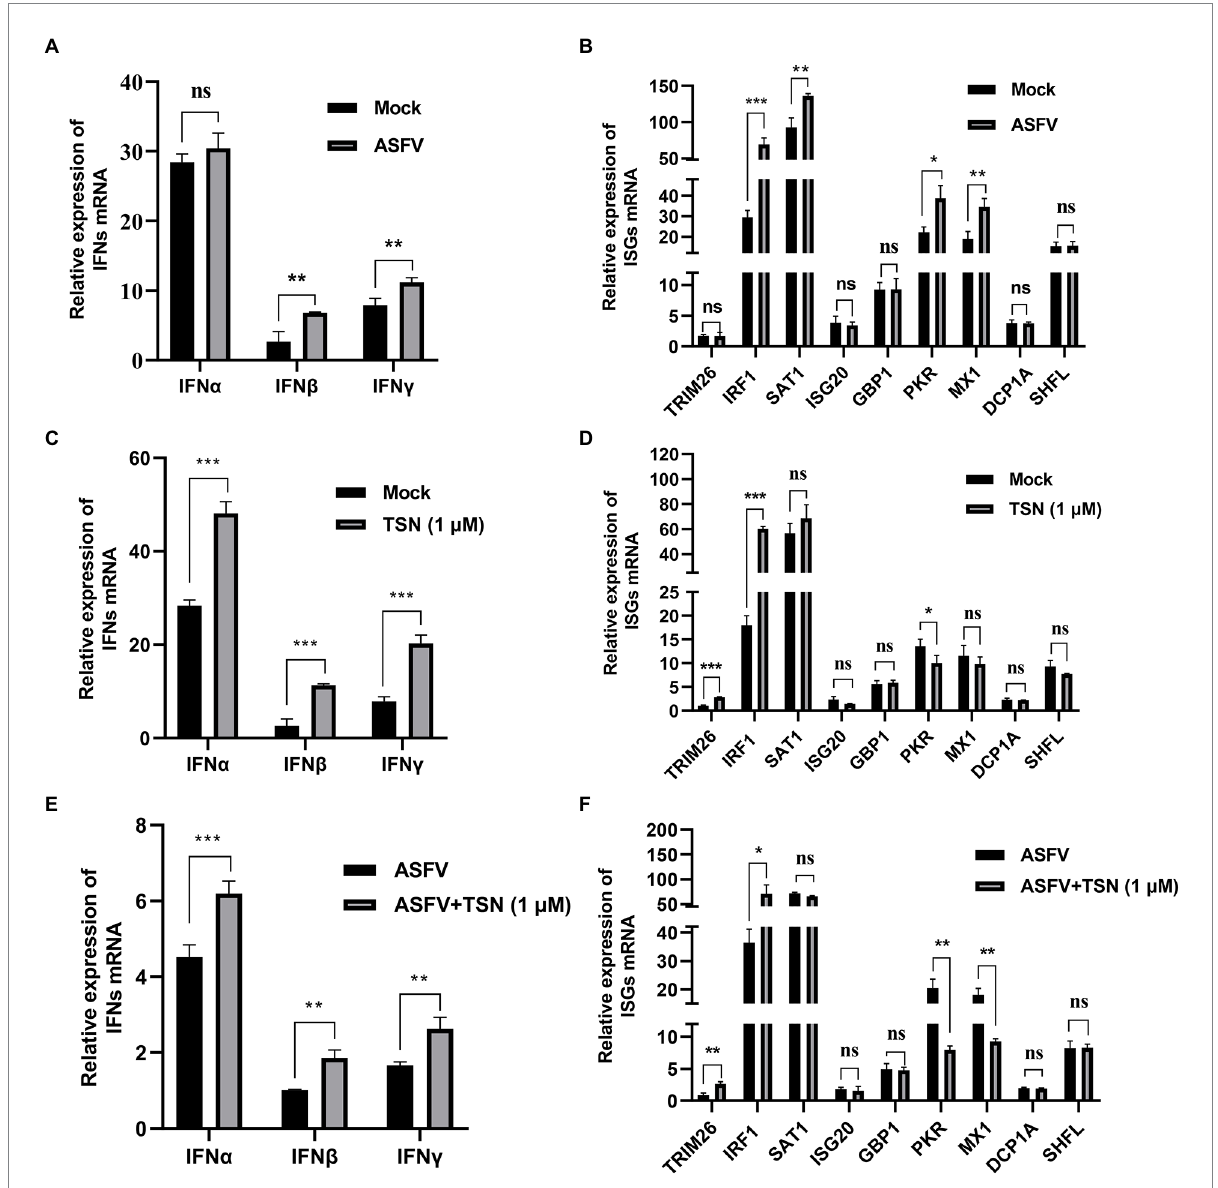
FIGURE 9 Effects of TSN on the mRNA expression of IFNs and 9 ISGs in PAMs. 0.014 MOI ASFV infected the PAMs for 24 h to test its effect on the expression level of IFNs (IFN α , IFN β and IFN γ ) and 9 ISGs (TRIM26, IRF1, SAT1, ISG20, GBP1, PKR, MX1, DCP1A and SHFL). Besides, 1 μ M TSN was added to PAMs with or without ASFV infection (0.014 MOI) for 24 h to test its effect on the expression of IFNs (IFN α , IFN β and IFN γ ) and 9 ISGs (TRIM26, IRF1, SAT1, ISG20, GBP1, PKR, MX1, DCP1A and SHFL). The vertical axis shows the relative expression level (fold-change) of IFNs or 9 ISGs mRNA. The fold-changes were calculated by the 2 ∆∆CT method and normalized by IFN β level (A,C,E) or TRIM26 level (B,D,F) in mock or ASFV group. (A) The mRNA level of IFN α , IFN β and IFN γ in PAMs with ASFV infection was analyzed using RT-qPCR. (B) The mRNA level of 9 ISGs in PAMs with ASFV infection was analyzed using RT-qPCR. (C) The mRNA levels of IFN α , IFN β and IFN γ in PAMs with or without TSN treatment were analyzed using RT-qPCR. (D) The mRNA levels of 9 ISGs in PAMs with or without TSN treatment were analyzed using RT-qPCR. (E) The mRNA levels of IFN α , IFN β and IFN γ in ASFV-infected PAMs with or without TSN treatment were analyzed using RT-qPCR. (F) The mRNA levels of 9 ISGs in ASFV-infected PAMs with or without TSN treatment were analyzed using RT-qPCR. *** denotes p < 0.001; ** denotes p < 0.01; * denotes p < 0.05; ns denotes not